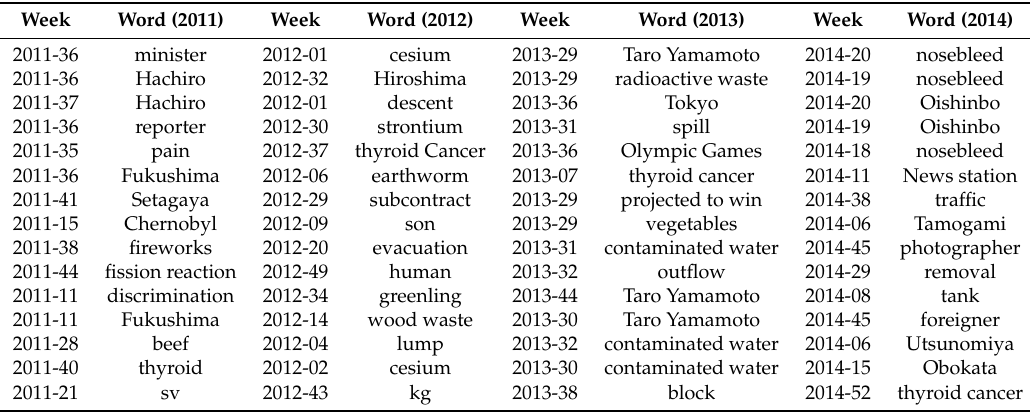
Table 2. Top 20 popular topics for which the scores calculated using the proposed method were high for each year, from 2011 to